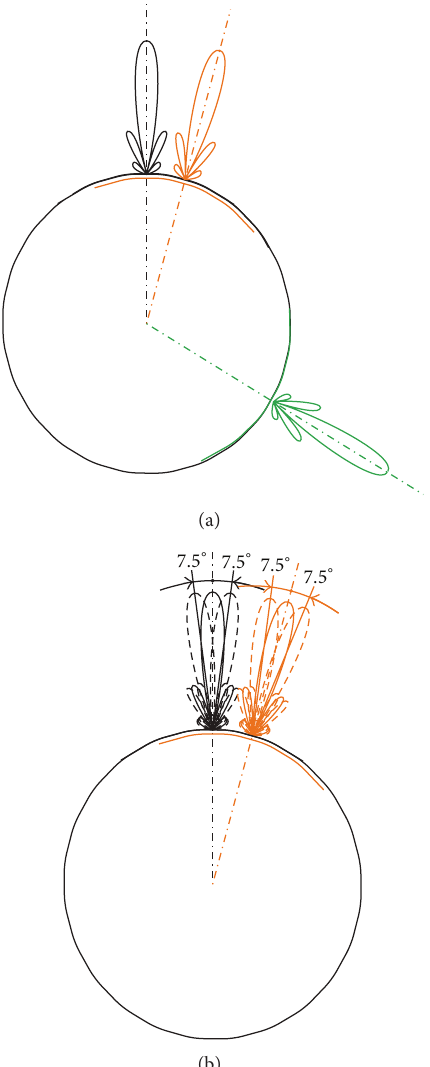
Figure 4: Smart antenna functionality: (a) three possible virtual arrays (black, orange, and green) two of which are largely superim- posed; (b) required scan capability from each virtual array to fully scan the horizontal